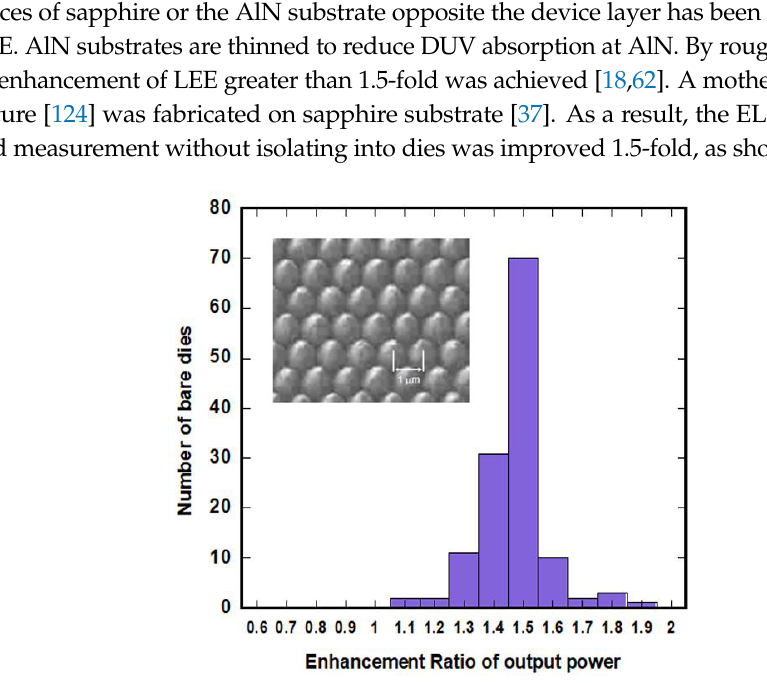
Figure 7. Relative increases in EL output power measured by wafer prober without dicing the LED wafers shown as a histogram. The inset is a scanning micro scope (SEM) image of the moth-eye (PhC) structure fabricated on sapphire. After isolating into dies from the LED wafer with maintaining the sapphire substrate thickness at 430 µ m, the improvement in the EL output was reduced to about 5% because the contribution of sapphire sidewalls in increasing LEE. (Graph is permitted to be reproduced from Appl. Phys. Express [37]. © Japan Society Applied